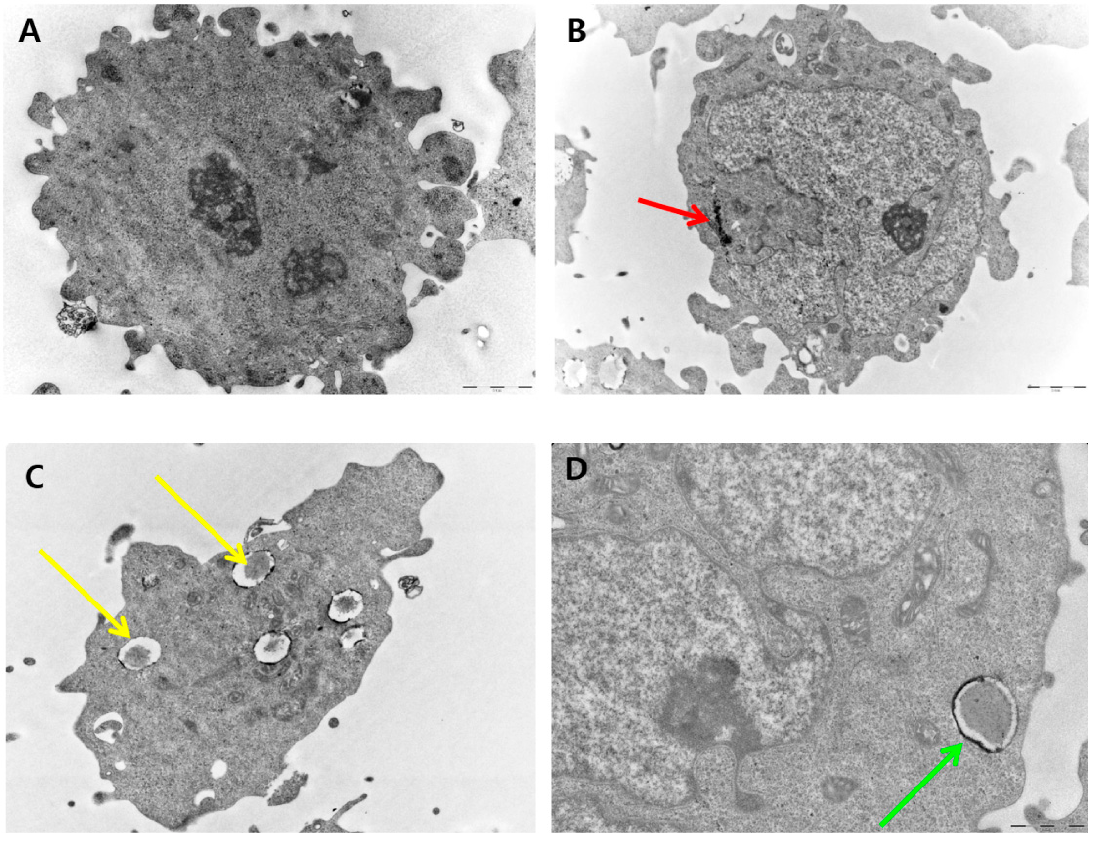
Figure 10. Cont. Figure 10.